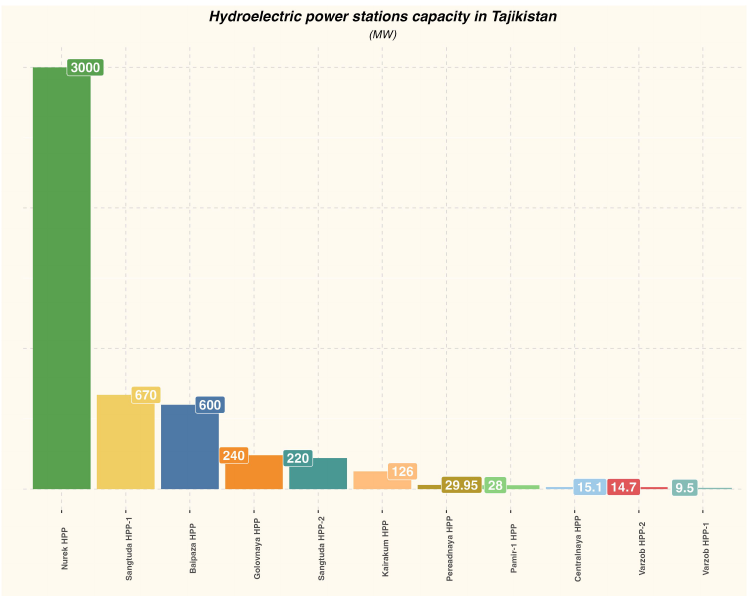
Figure 6. Hydroelectric power stations in Tajikistan and their capacities. Data source: Tajikistan Energy Ministry: Jelektrojenergeticheskaja Sistema.